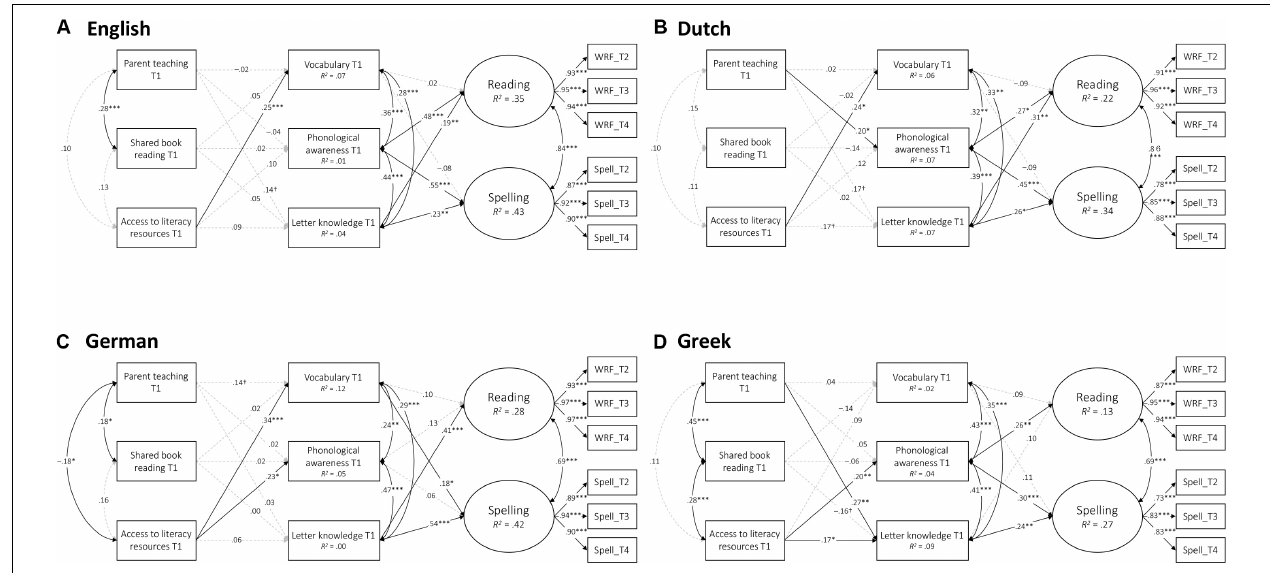
FIGURE 1 | The models for the associations between HLE, emergent literacy skills, and later literacy outcomes in each orthography (standard solution): (A) English; (B) Dutch; (C) German; and (D) Greek. WRF, word reading fluency; T1, Time 1; T2, Time 3; T1, Time 3; T4, Time 4. † p < 0.10, ∗ p < 0.05, ∗∗ p < 0.01, ∗∗∗ p < 0.001. TABLE 1 | Descriptive statistics for parent measures within each orthography. English Dutch